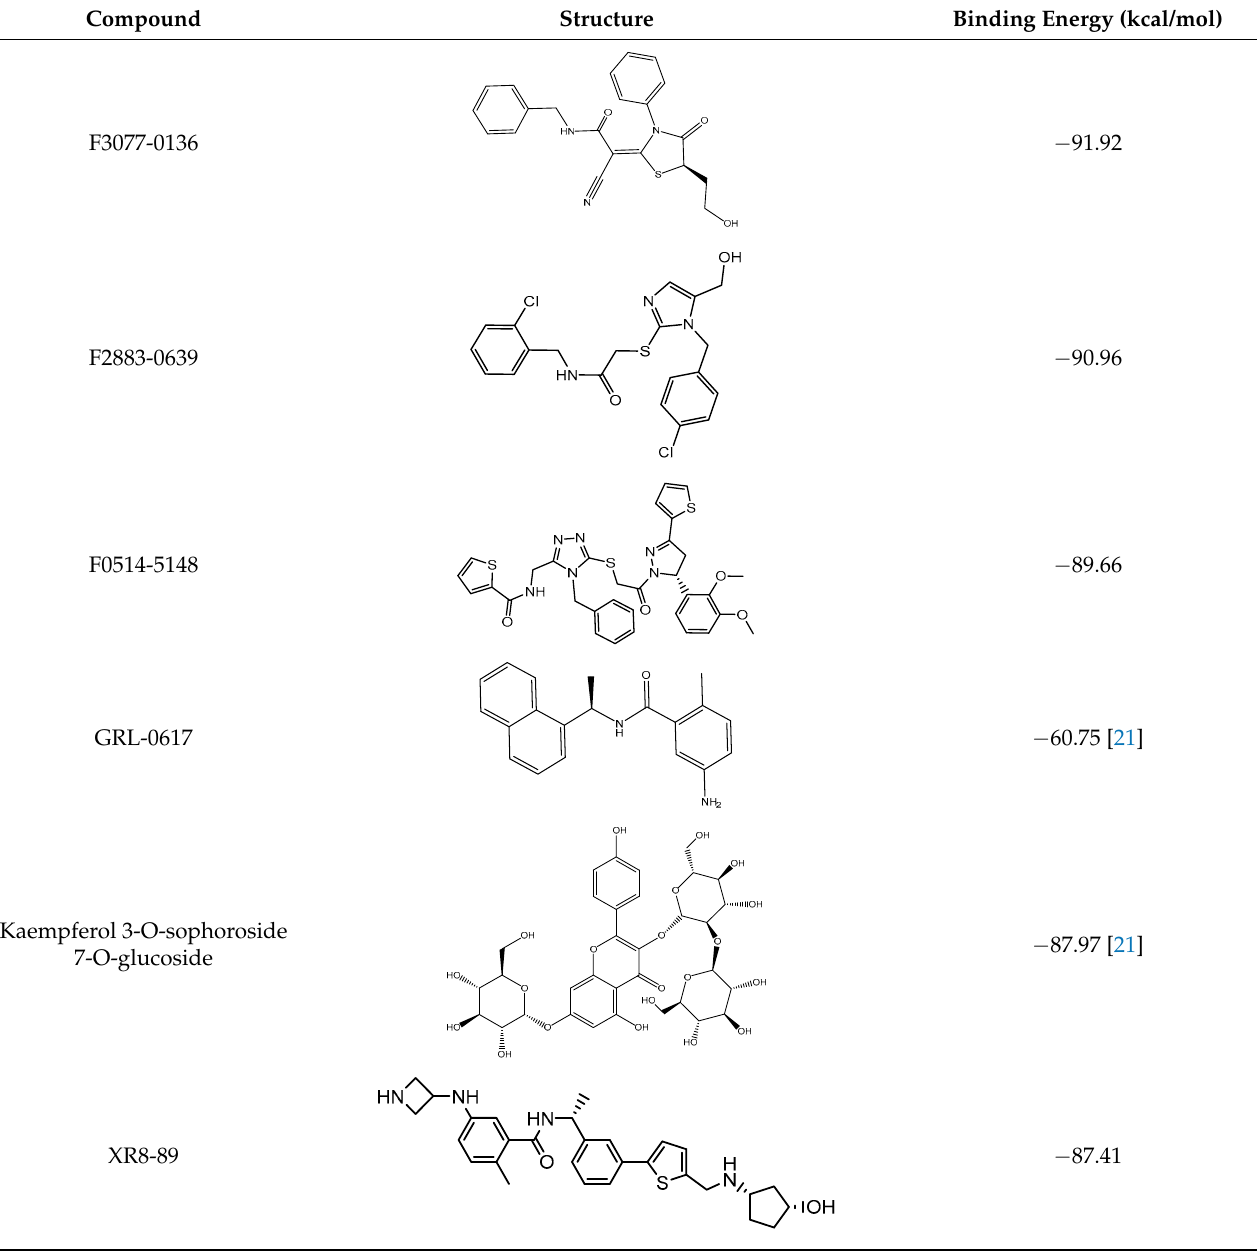
Table 1. The estimated binding energies of the top three compounds and the control